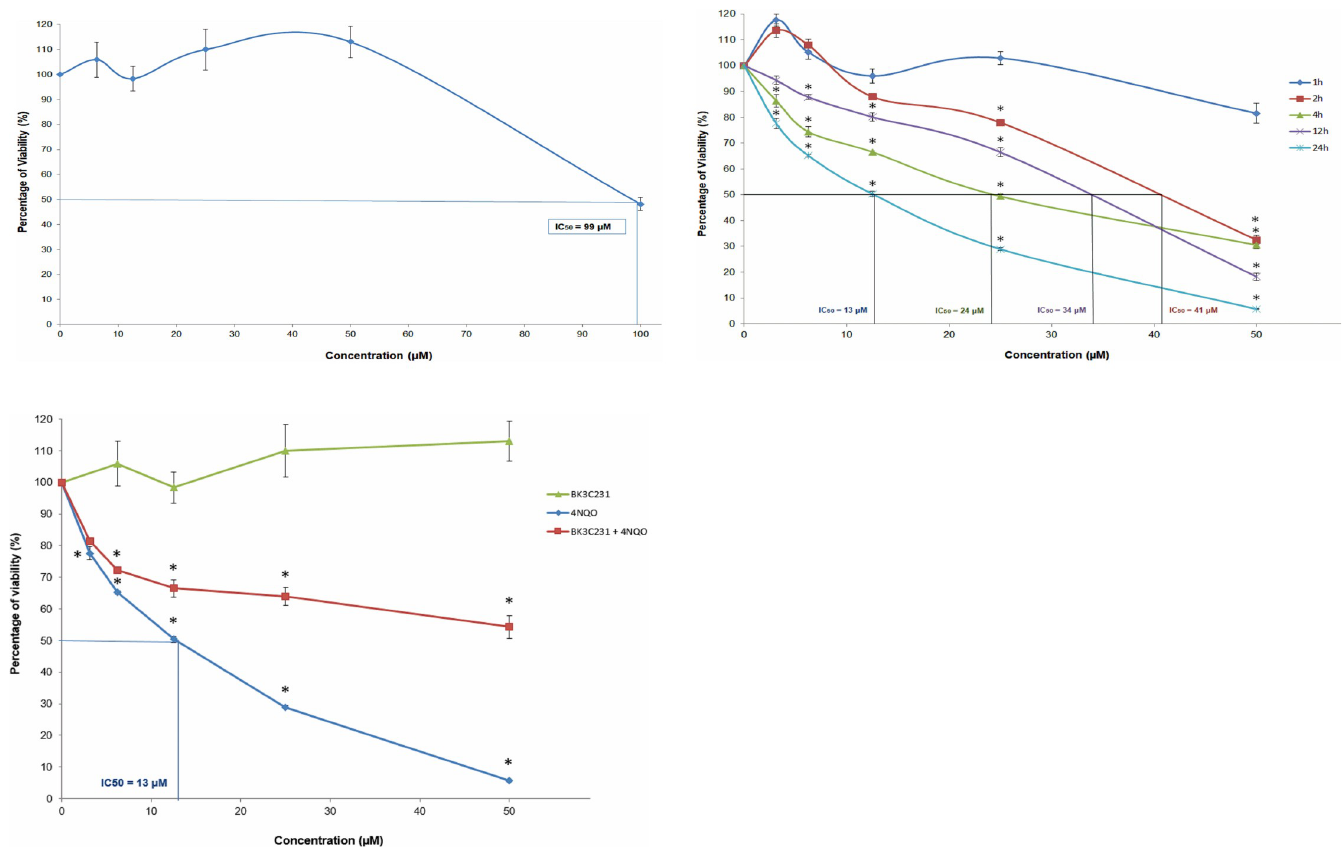
Fig 2. Effect of BK3C231 and 4NQO on the viability of CCD-18Co cells as assessed by MTT assay. (A) Cells were treated with BK3C231 from 6.25 μ M till 100 μ M for 24h. An IC 50 value of 99 μ M was observed. (B) Cells were treated with 4NQO from 3.125 μ M till 50 μ M for 1h (no IC 50 value), 2h (IC 50 value was 41 μ M), 4h (IC 50 value was 24 μ M), 12h (IC 50 value was 34 μ M) and 24h (IC 50 value was 13 μ M). (C) Cells were pretreated with BK3C231 at 50 μ M for 2h prior to 4NQO treatment from 3.125 μ M till 50 μ M for subsequent 22h (no IC 50 value) in comparison to BK3C231-treated (no IC 50 value) and 4NQO-treated cells (IC 50 value was 13 μ M). Each data point was obtained from three independent experimental replicates and expressed as mean ± SEM of percentage of cell viability. � p < 0.05 against negative control.